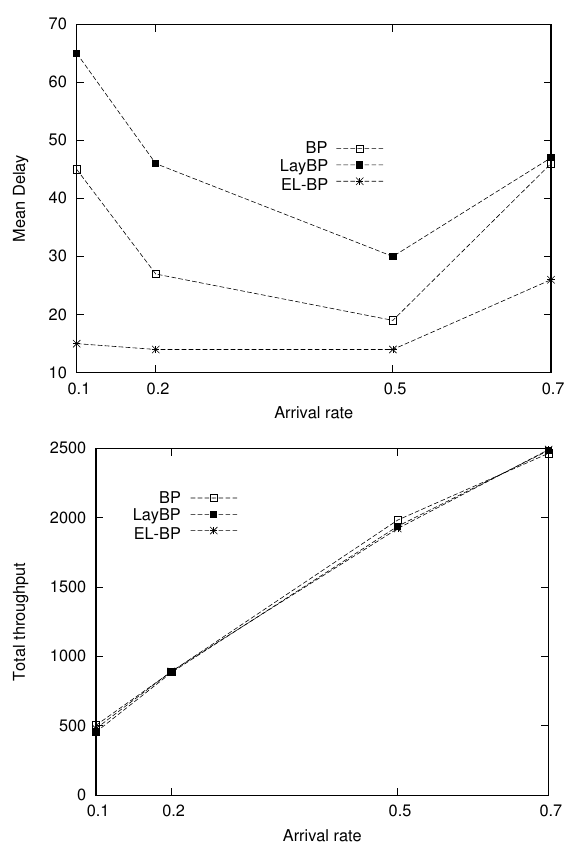
Figure 13. Impact of moving nodes on the delay and on the throughput performance of BP , L ay BP and E L−BP for the dynamic network with the 3